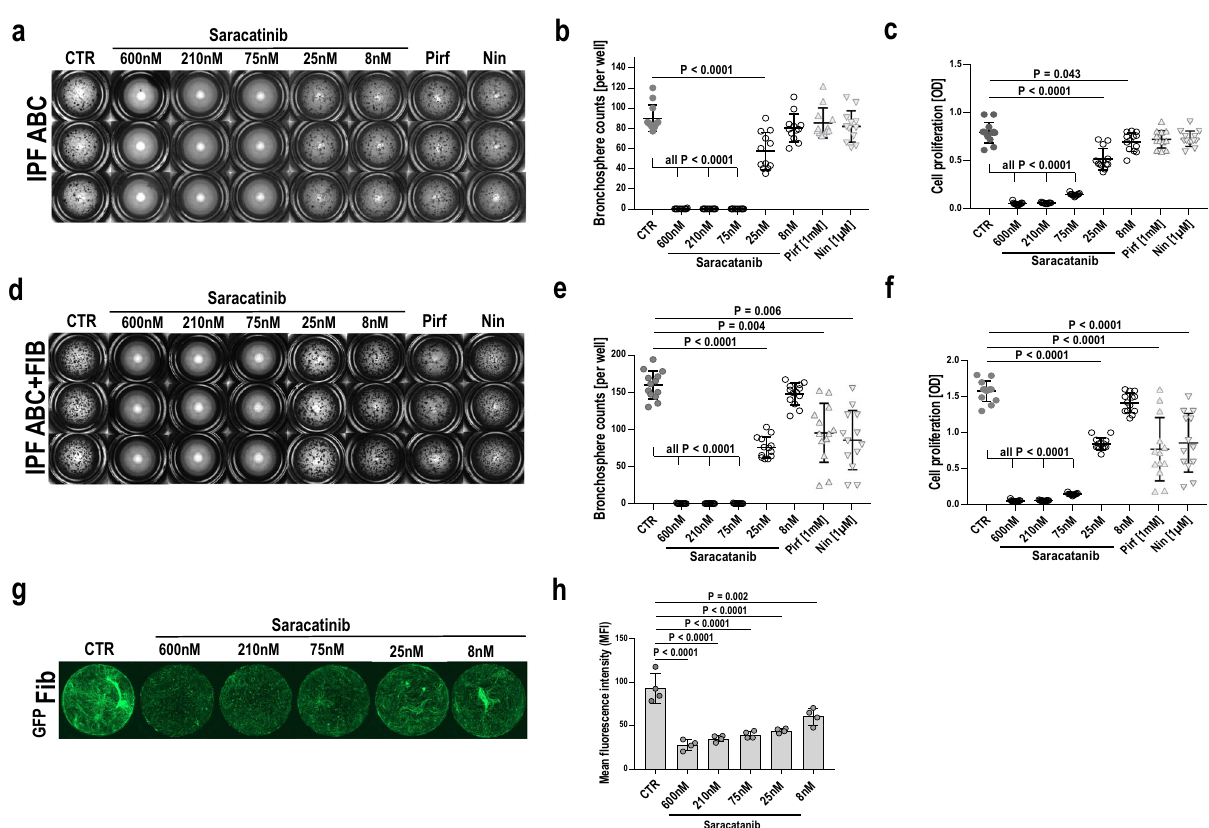
Fig. 5 | SRC-inhibitor saracatinib abrogates bronchosphere formation. a – f Bronchosphere assays of human IPF-ABCs were performed w/wo IPF lung fi broblasts for 21 days. Cell cultures ( n =12, in triplicates) were treated with either vehicle, saracatinib (600, 210, 75, 25, 8nM), pirfenidone (1mM) or nintedanib (1 µ M). b Saracatinibabrogatedsphereformationdose-dependentlywhileadoseof pirfenidone or nintedanib, which was higher than usually applied in humans, did notchangebronchospherecounts(mean±SD). c Cellproliferationasmeasuredby MTTassay wassigni fi cantlyreduced by saracatinibtreatment in a dose-dependent manner and slightly by pirfenidone and nintedanib (mean±SD). d , e Saracatinib treatment also abrogated sphere formation dose-dependently in the presence of